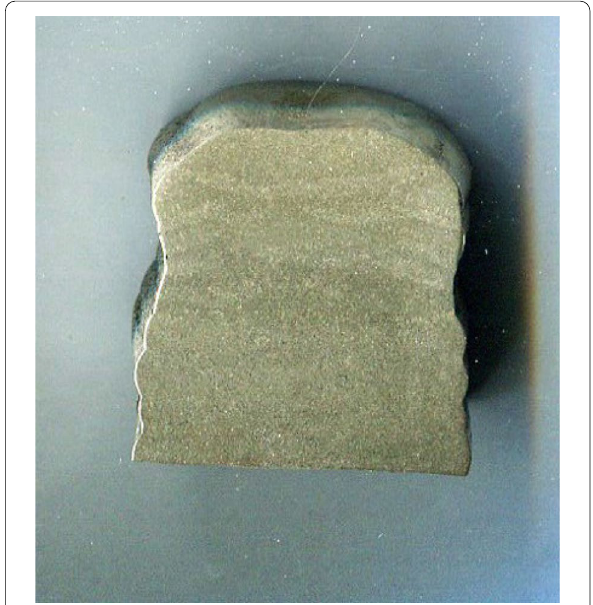
Table 3 Chemical composition (wt%) of the CuMn formed by wire arc additive manufacturing Sample Mn Ni Al Fe Cu CuMn 13 Al 7